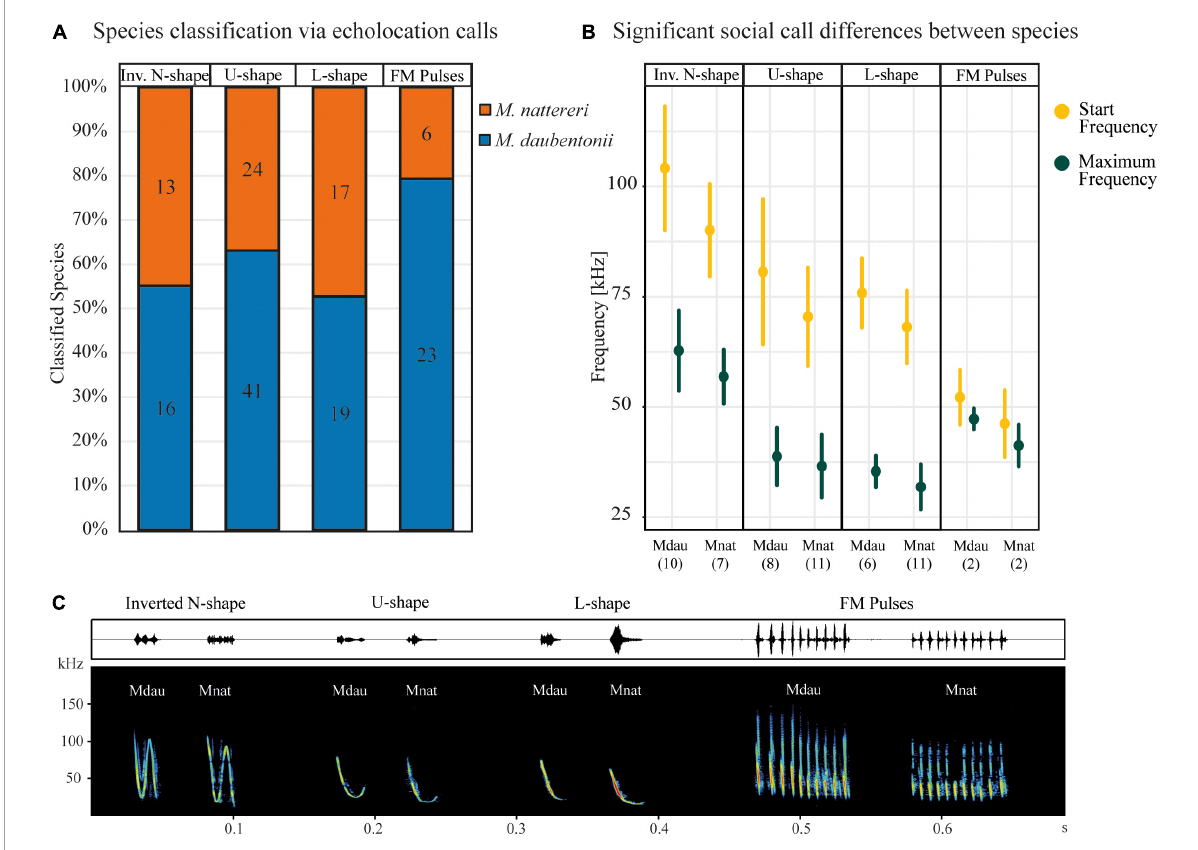
FIGURE5 (A) Number and proportion of classified species based on the classification of echolocation snippets surrounding a social call. The total number is given within the columns. (B) For the classified calls, start frequency and maximum frequency (averaged over the entire call) differed significantly between species. Mean and standard deviation per species are depicted in the graph, number of analyzed calls per species is given in parentheses. (C) Examples of calls per species based on the classification results. Mdau, Myotis daubentonii ; Mnat, Myotis nattereri